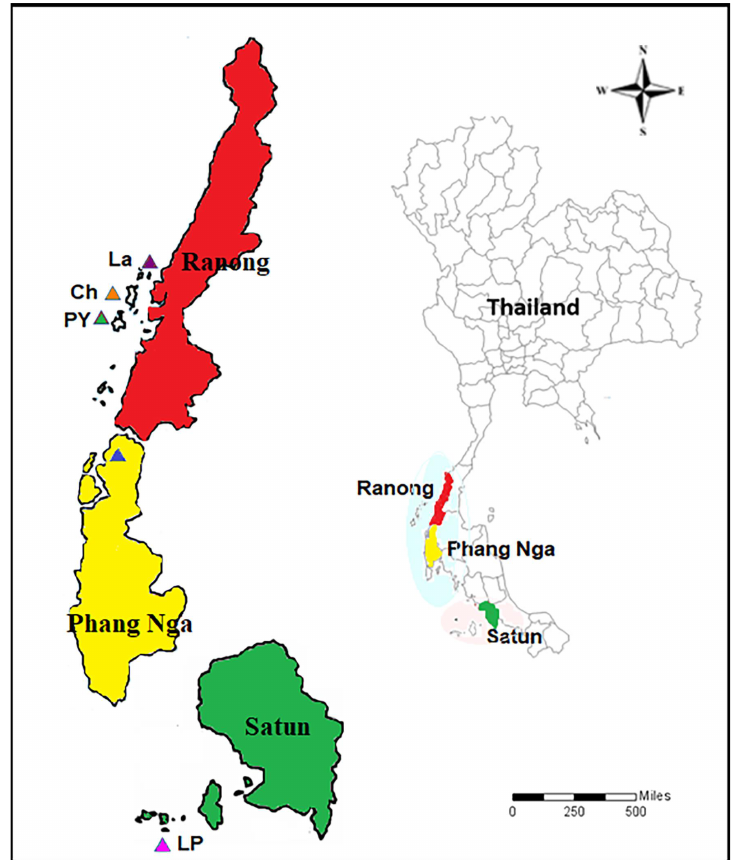
Figure 1. Locations of study areas. Chang Island (CH), Payam Island (PY), Lao Island (LA), Ban Thub Tawan Village (TT), and Lipe Island (LP) as a part of Ranong, Phang Nga, and Satun Provinces, Thailand.